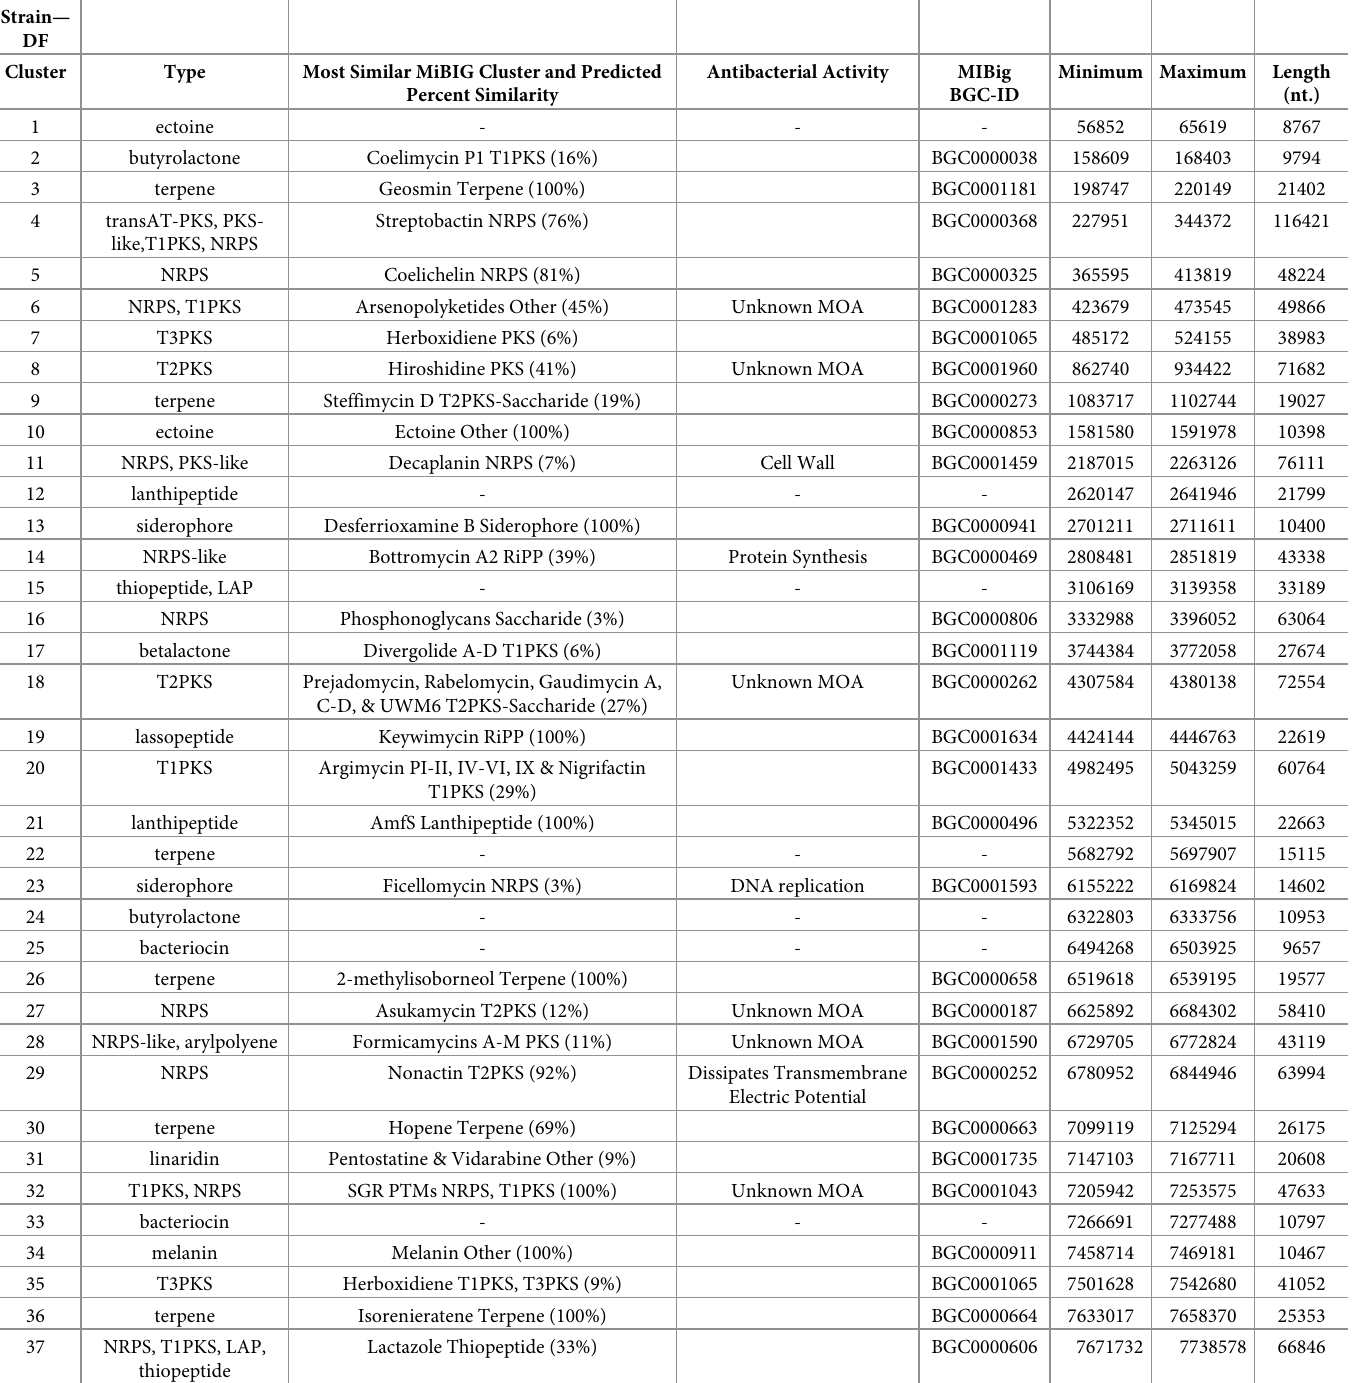
Table 5. BGCs encoded within the closed genome sequence of strain